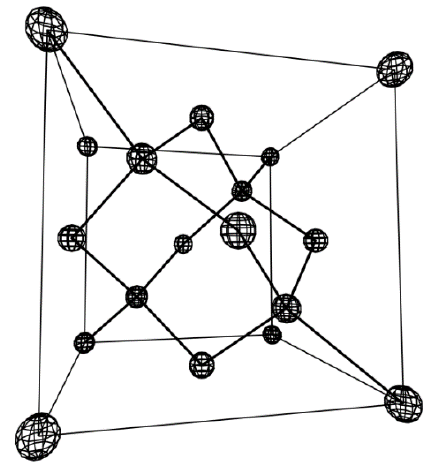
Figure 14. Unit cell of a silicon crystal.